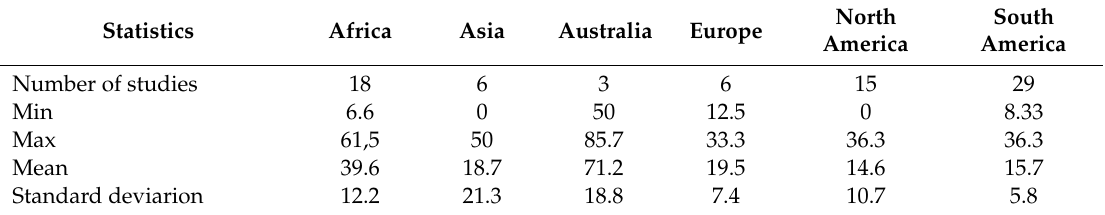
Table 2. Synopsis of the percentage (and dispersion measures) of venomous species within snake assemblages among continents, on the basis of the selected studies.